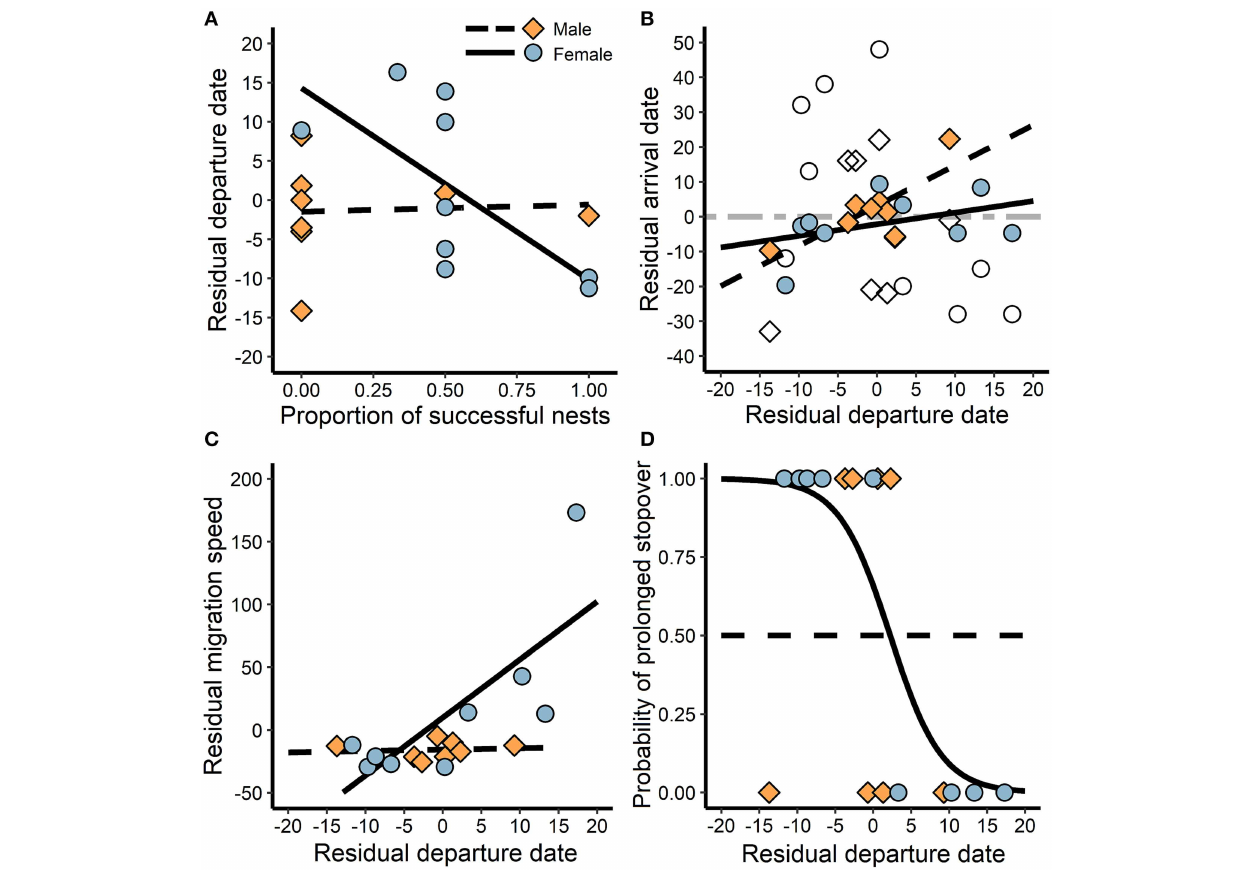
FIGURE 3 | The association between breeding success and cascading migration behaviors during autumn migration. (A) The relationship between breeding success and timing of departure from the breeding site, and (B) the subsequent association between departure date and arrival at the first prolonged non-breeding site (black lines) and the winter site (dashed gray line). The gray line depicts the relationship for both males and females because there were no sex differences, but the empty points indicate males and females separately for comparison. Additionally, (C) late departing females increased migration speed to the first stopover, and (D) reduced use of prolonged stopovers following delayed departure. Residuals were calculated by subtracting from the mean such that positive is greater and negative is less than